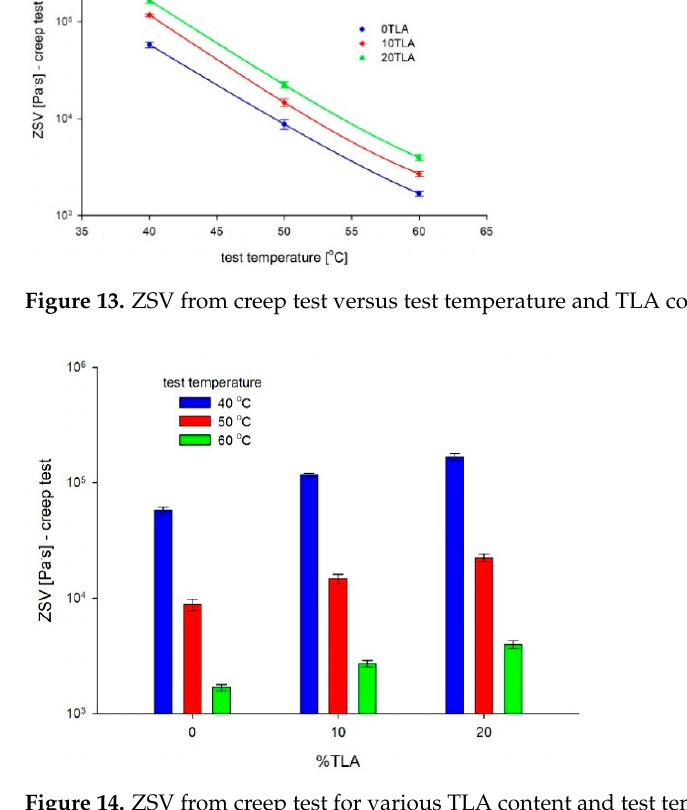
Figure 14. ZSV from creep test for various TLA content and test temperatures.